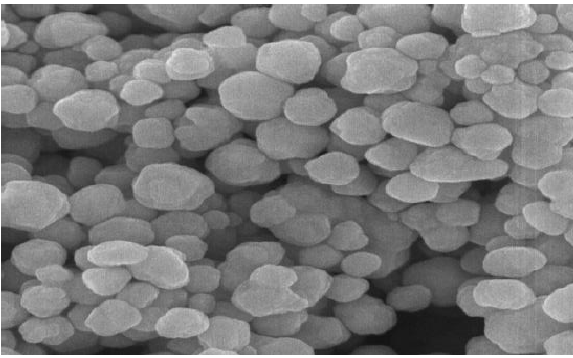
1.Morphology of Silver nanoparticles (20nm) Hongwu International Group Ltd. S* = Significant (P < 0.05)